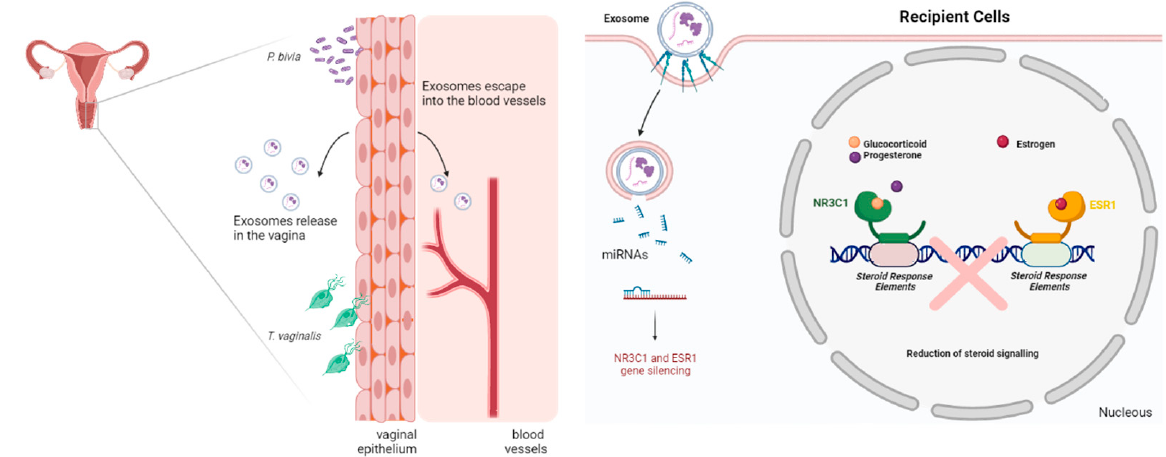
Figure 5. Summary of conceptual framework for testing the causative link between parasite/bacterial colonization and post-transcriptional regulation of human female reproductive function and homeostasis in reproductive tissues. The model relies on the ability of human vaginal epithelial cells to mount differential miRNA expression in response to pathogenic or homeostatic colonization by a common parasite ( T. vaginalis ), a signature BV pathobiont ( P. bivia ) or signature vaginal health bacteria ( L. crispatus ). Differentially expressed miRNAs will be released encapsuled in extracellular vesicles (EV or exosomes) to potentially exert paracrine or systemic/endocrine function in recipient tissues. Quantifying EV-miRNAs with predicted reproductive tissues and validated gene targets and pathways, such as steroid hormone signaling or gynecologic cancer, supports molecular causation (Image created with BioRender.com, accessed on 19 December 2022).